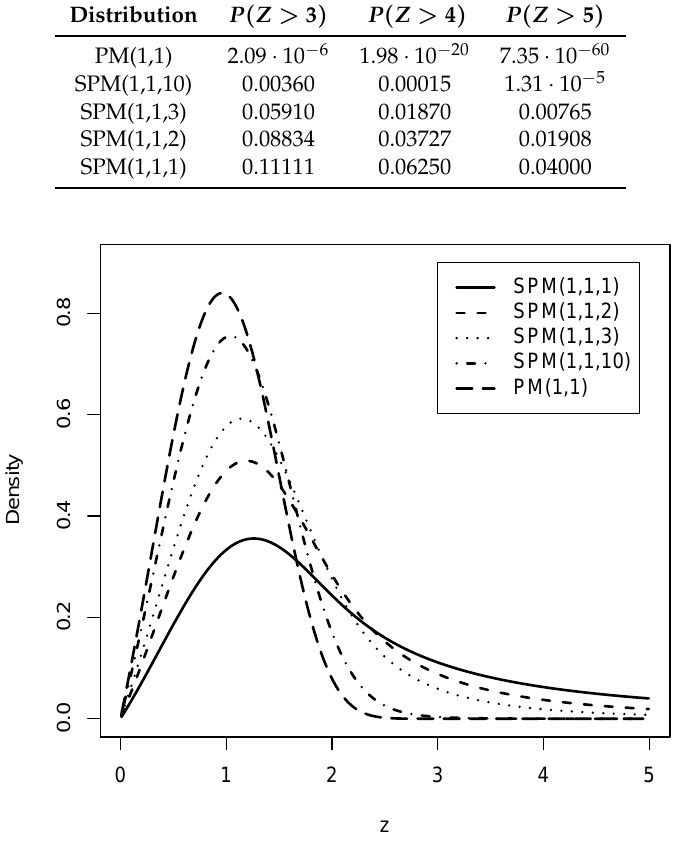
Figure 1. Plot of the SPM